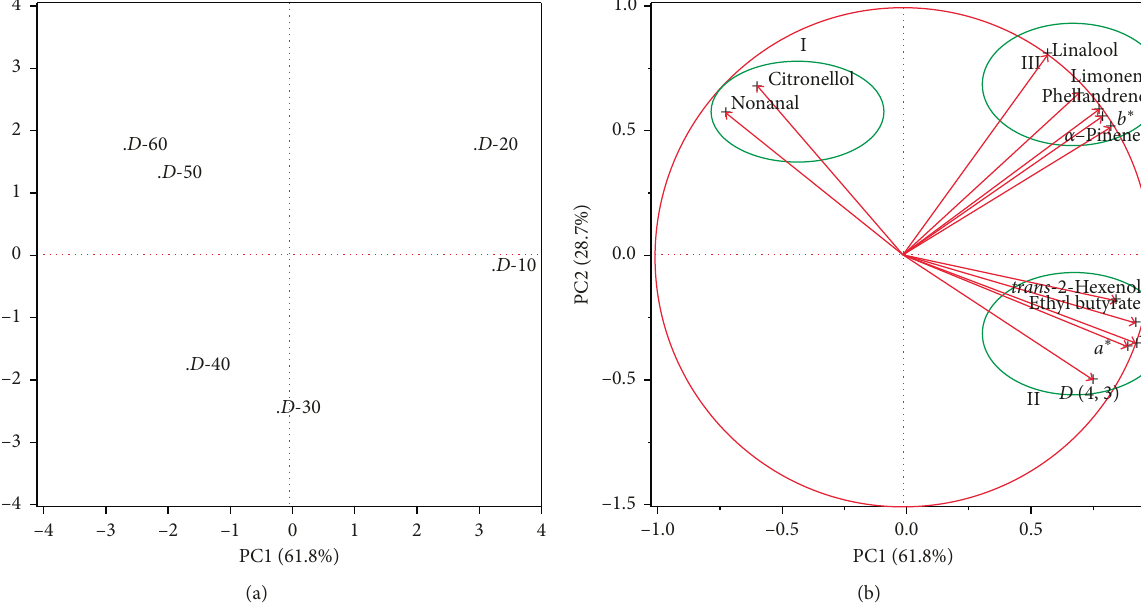
Figure 4: PCA plots for changes in quality of orange juice during DPCD treatment (40MPa, 55 ° C). (a) PCA scores of the samples; (b) PCA loadings of the parameters. D -10, 20, 30, 40, 50, and 60 indicate DPCD duration times of 10, 20, 30, 40, 50, and 60min,